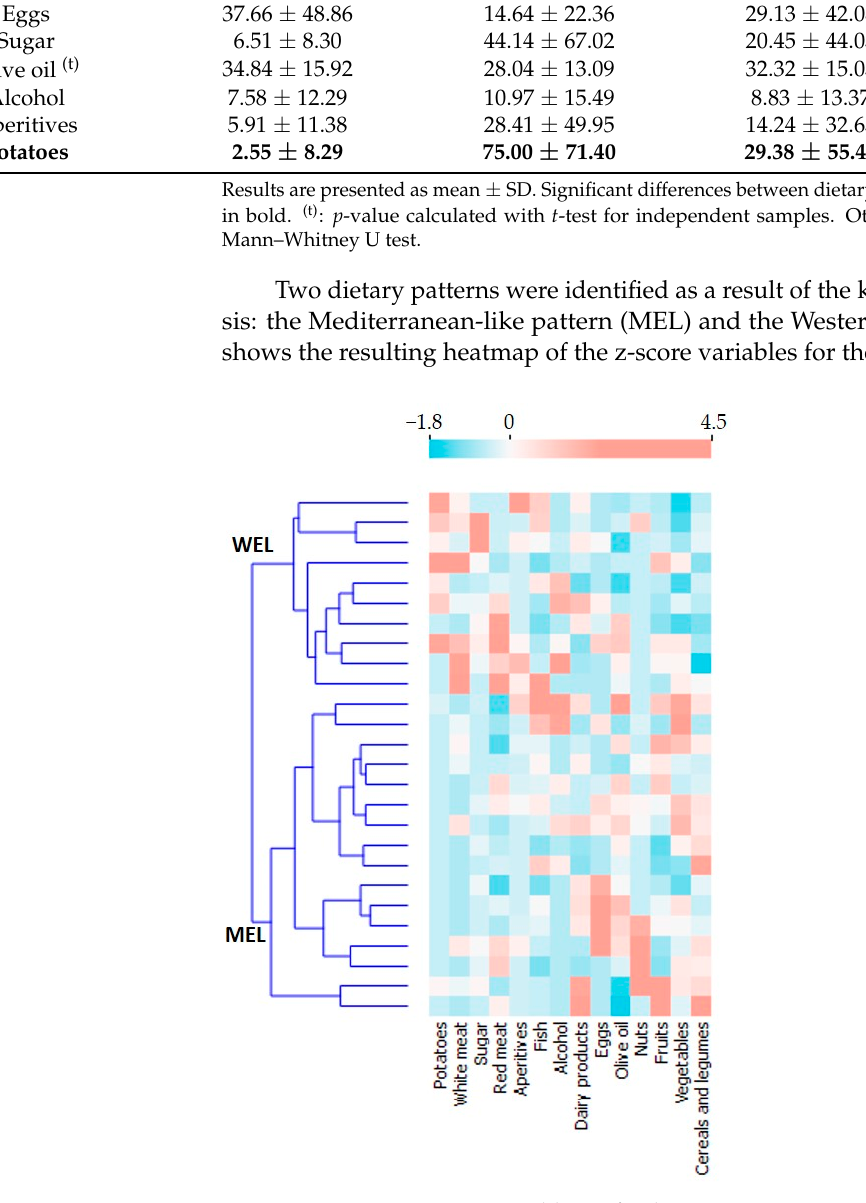
Figure 1. Heatmap z-score variables 14 food